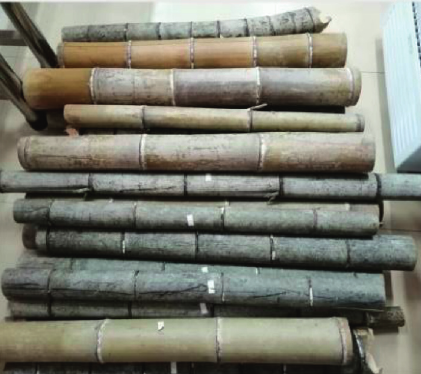
Figure 10: Experimental